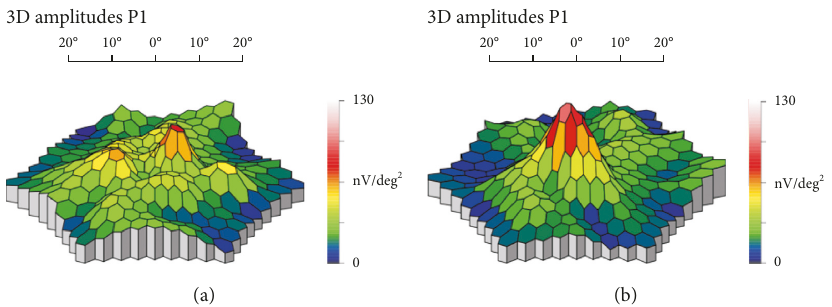
Figure 4: Three-dimensional topography of amplitude P1 of patient no. 4, before and after surgery for macular